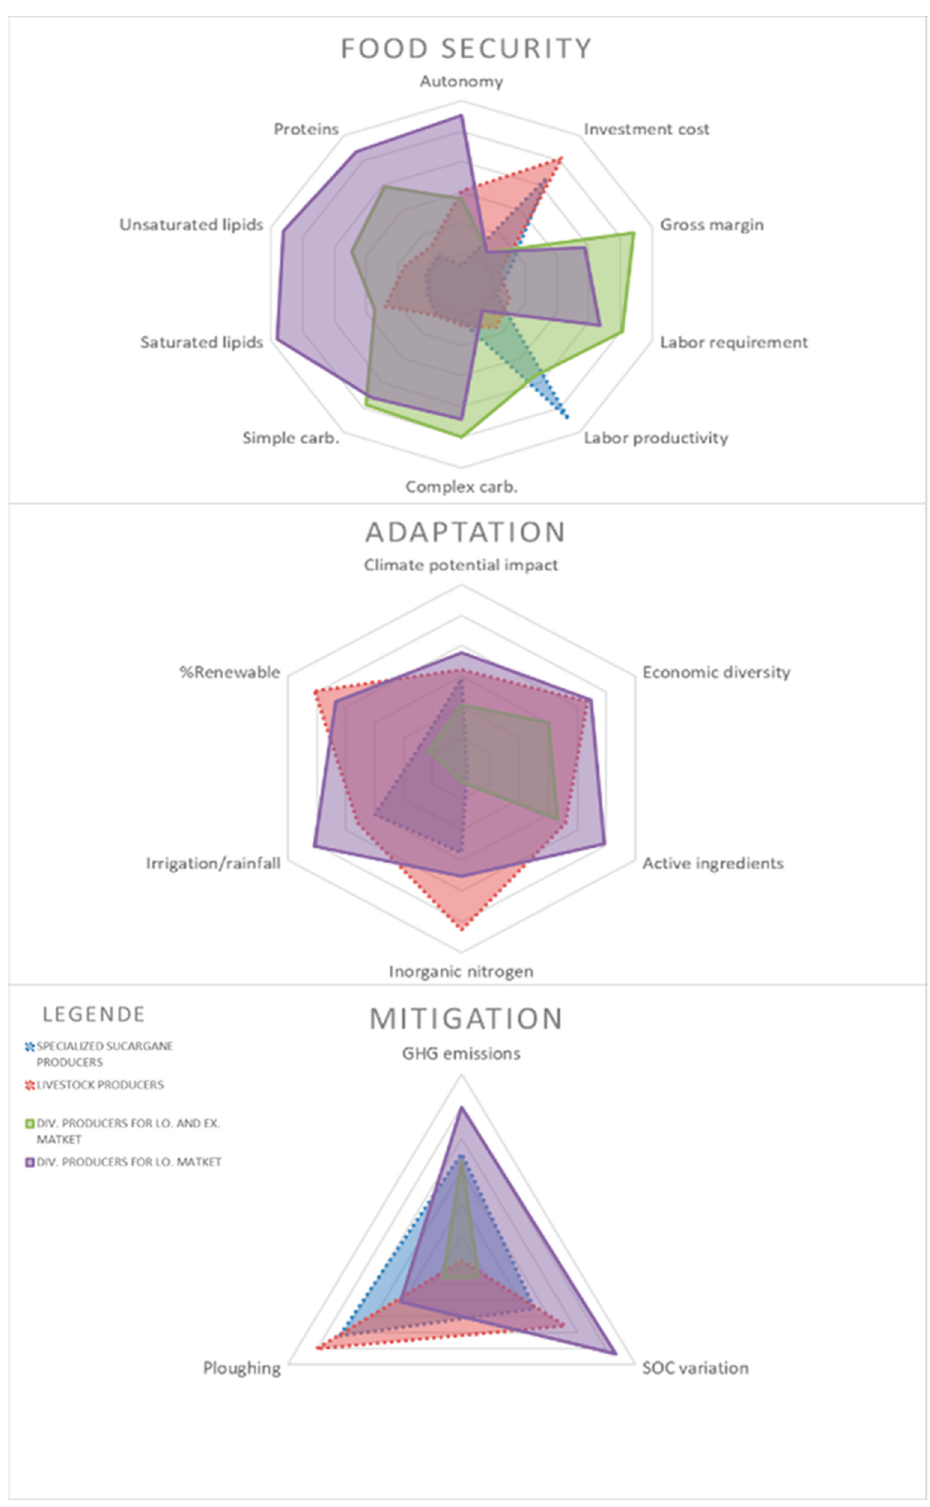
Figure 5. Radar charts of the relative scores for each dimension (food security, adaptation and mitigation). After mean-centering the scores, we multiplied by -1 the values of indicators that should decrease (Investment cost, Active ingredients, Inorganic nitrogen, Irrigation/rainfall, Potential climate impact, Plowing, GHG emissions) in order to obtain the same reading. Higher values corresponded to better performances.